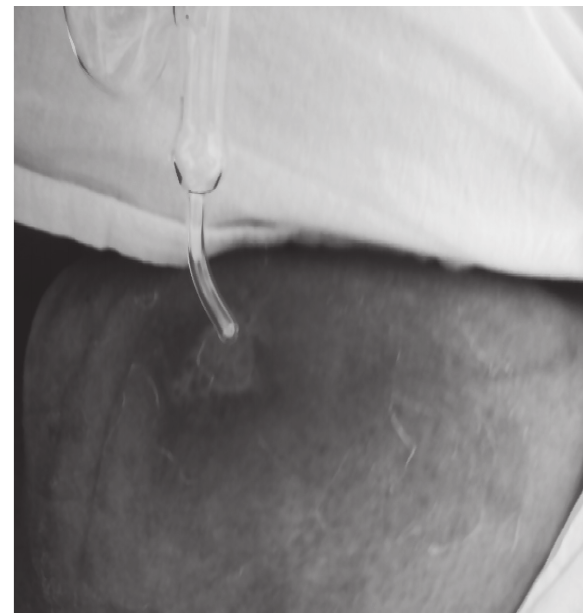
Figura 3 – Aplicação da microcorrente na úlcera Fonte: Dados da